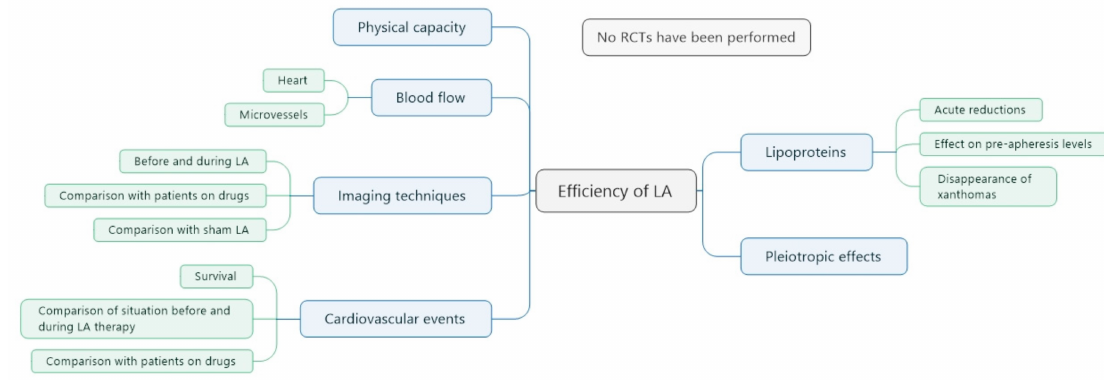
Figure 2. Criteria for evaluation of efficiency of LA. RCTs: randomized controlled